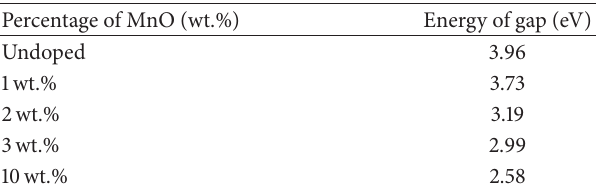
Table 4: Band gap energy for undoped and Mn-doped Zn 2 SiO 4 sintered at 600 ∘